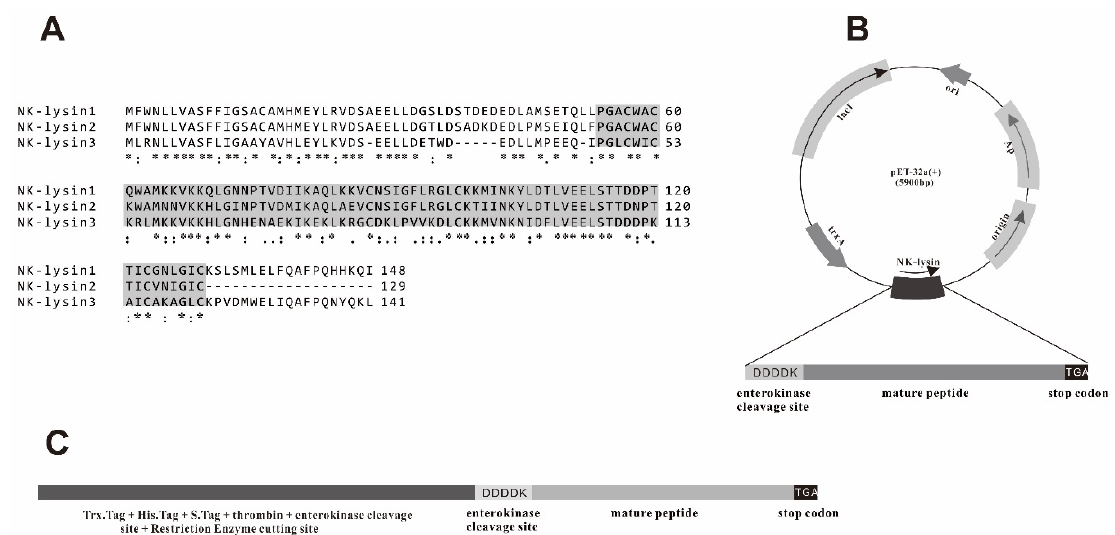
Figure 1. ( A ) Alignment of channel catfish NK ‐ lysin amino acid residues. The mature peptides (about 8.6 kDa) were indicated in gray background which were predicted by SMART and the report of Qun Wang et al. (2006) [36]. Regions of identity (*), strong similarity (:) and weak similarity (.) were indicated; ( B ) The construction of prokaryotic expression vector pET ‐ 32a ‐ mNKL. In order to obtain the recombinant mNKLs with similar structure of native NK ‐ lysins, the enterokinase cleavage site (DDDDK) and termination codon (TGA) were added in N ‐ terminal and C ‐ terminal of mNKLs, respectively; ( C ) Fusion protein produced as translation of pET ‐ 32a(+) vector.